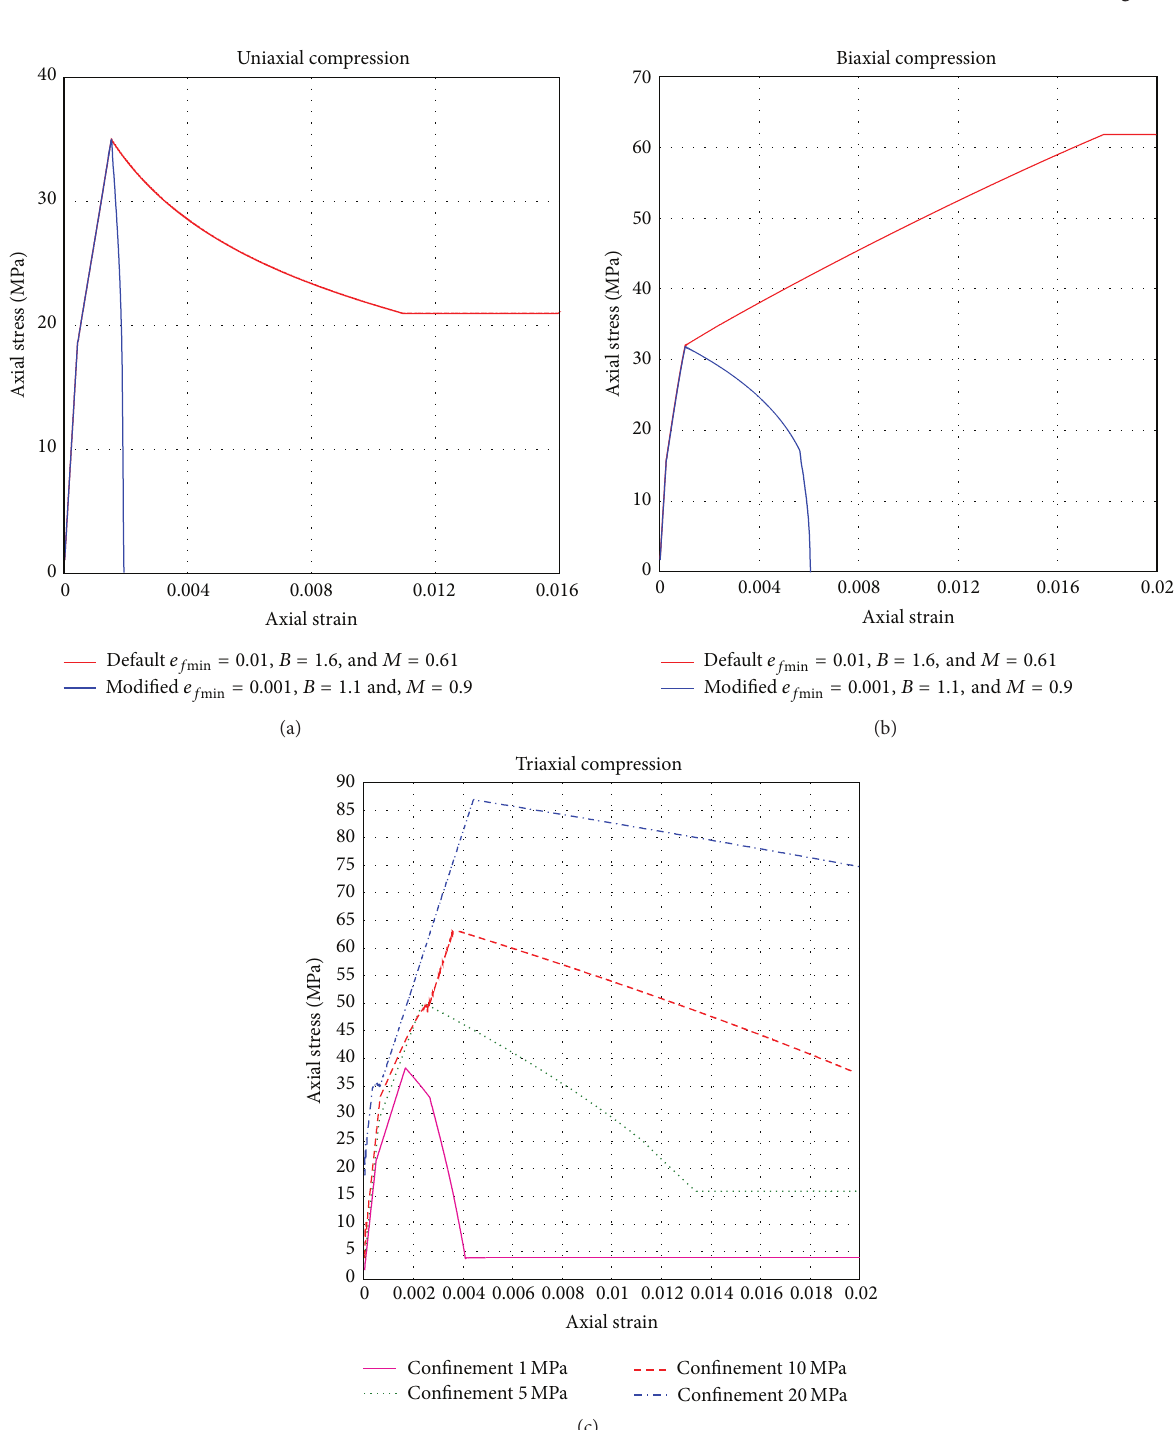
Figure 5: Comparison of compressive stress-strain curves generated by RHT model.